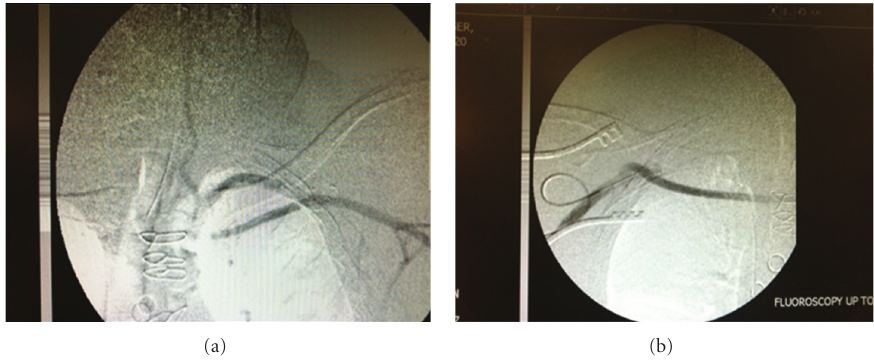
Figure 4: Restoration of flow in the left subclavian artery across a propaten graft from the right subclavian